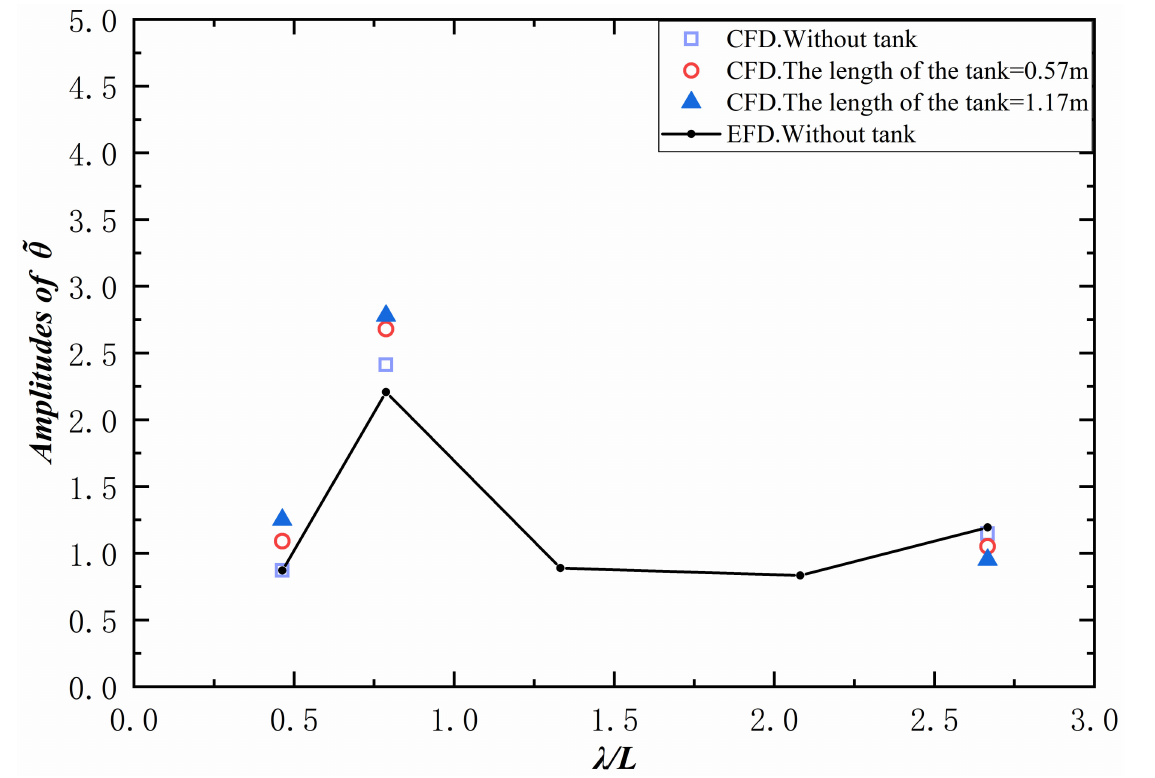
Figure 23. For the ship in beam waves, comparative roll amplitudes of the ship obtained from numerical simulations and experiment with and without